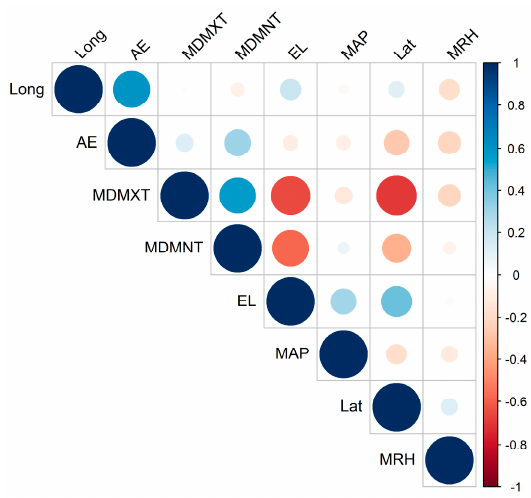
Figure 5. Intercorrelation matrix of the attributes selected in this study.